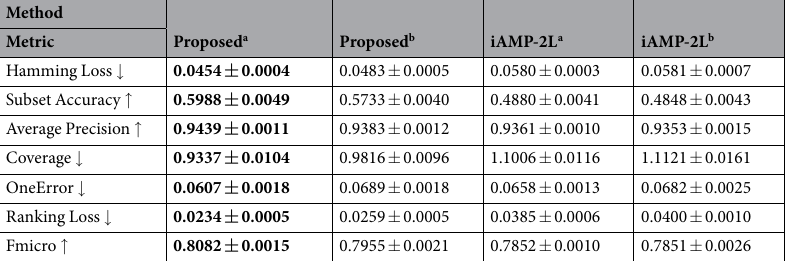
Table 8. The means and standard deviations of 5-CV results with the proposed method and iAMP-2L when testing on the original dataset. The superscript a indicates the feature extraction method in this work, and b indicates the PseAAC. ↓ means lower is better; ↑ means higher is better. The best value for each metric is in bold.